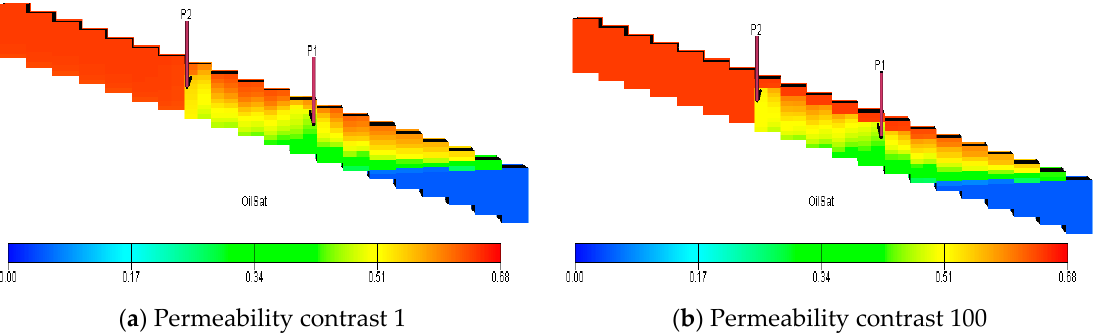
Figure 14. Oil saturation profiles before gas injection.